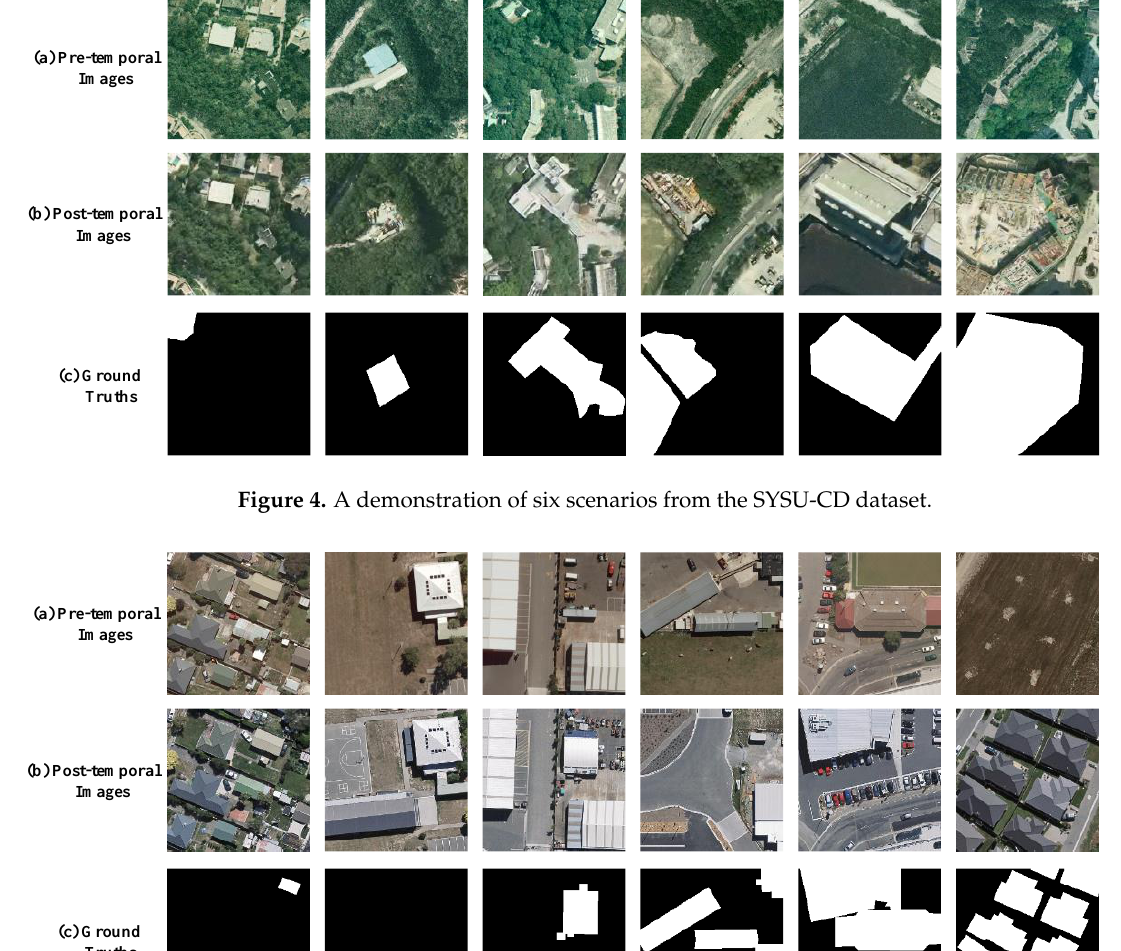
Figure 3. A demonstration of six scenarios from the LEVIR-CD dataset.